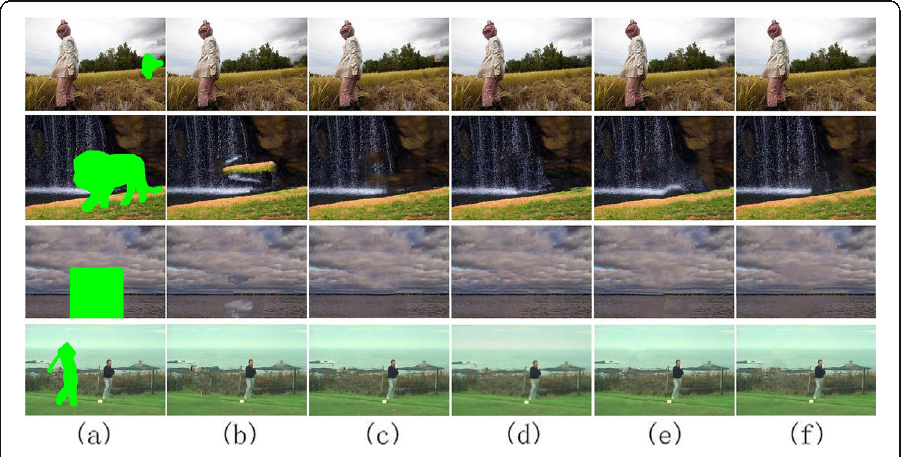
Fig. 7 Comparison of results in different scenes. a Input. b Criminisi ’ s results. c Komodakis ’ s results. d He ’ s result. e Le Meur ’ s results. f Our